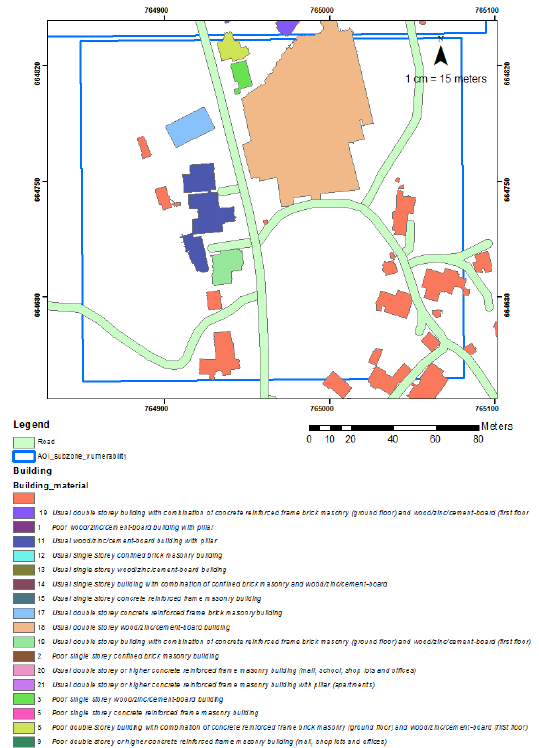
Figure 6. Example of building footprints classified into different building construction materials in